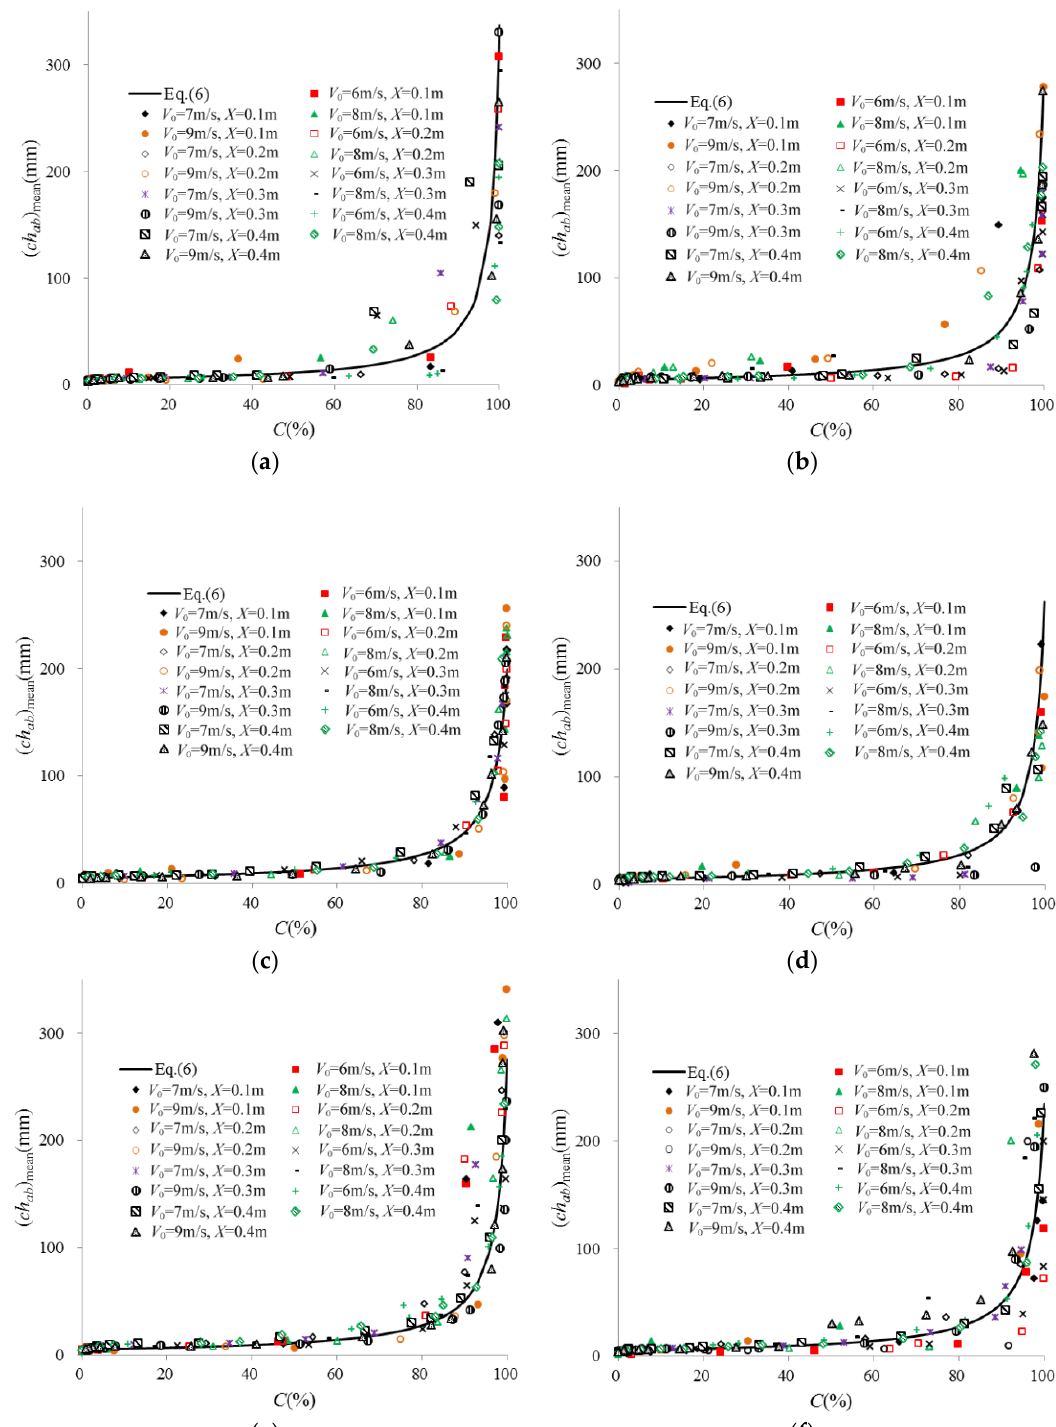
Figure 12. Measured air bubble chord length as a function of the air concentration. The solid lines are